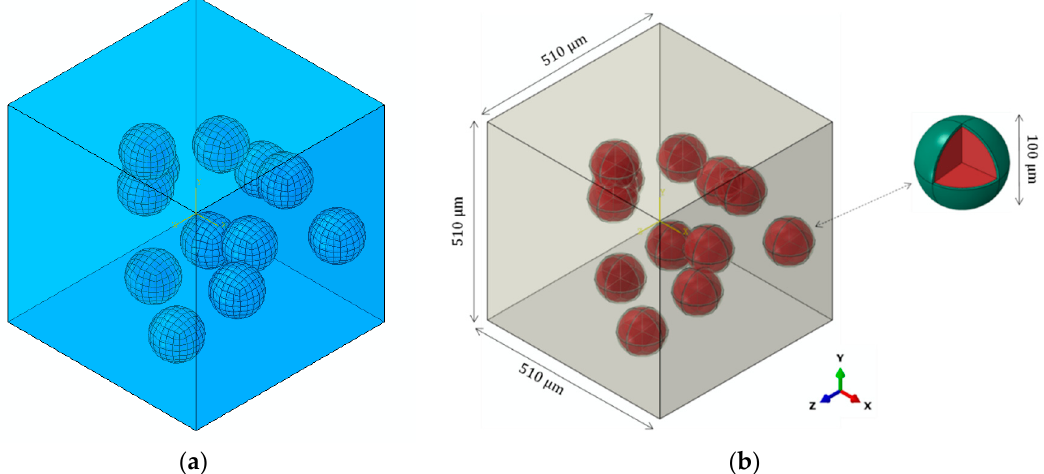
Figure 4. ( a ) The generated representative volume element (RVE) and ( b ) dimensions.